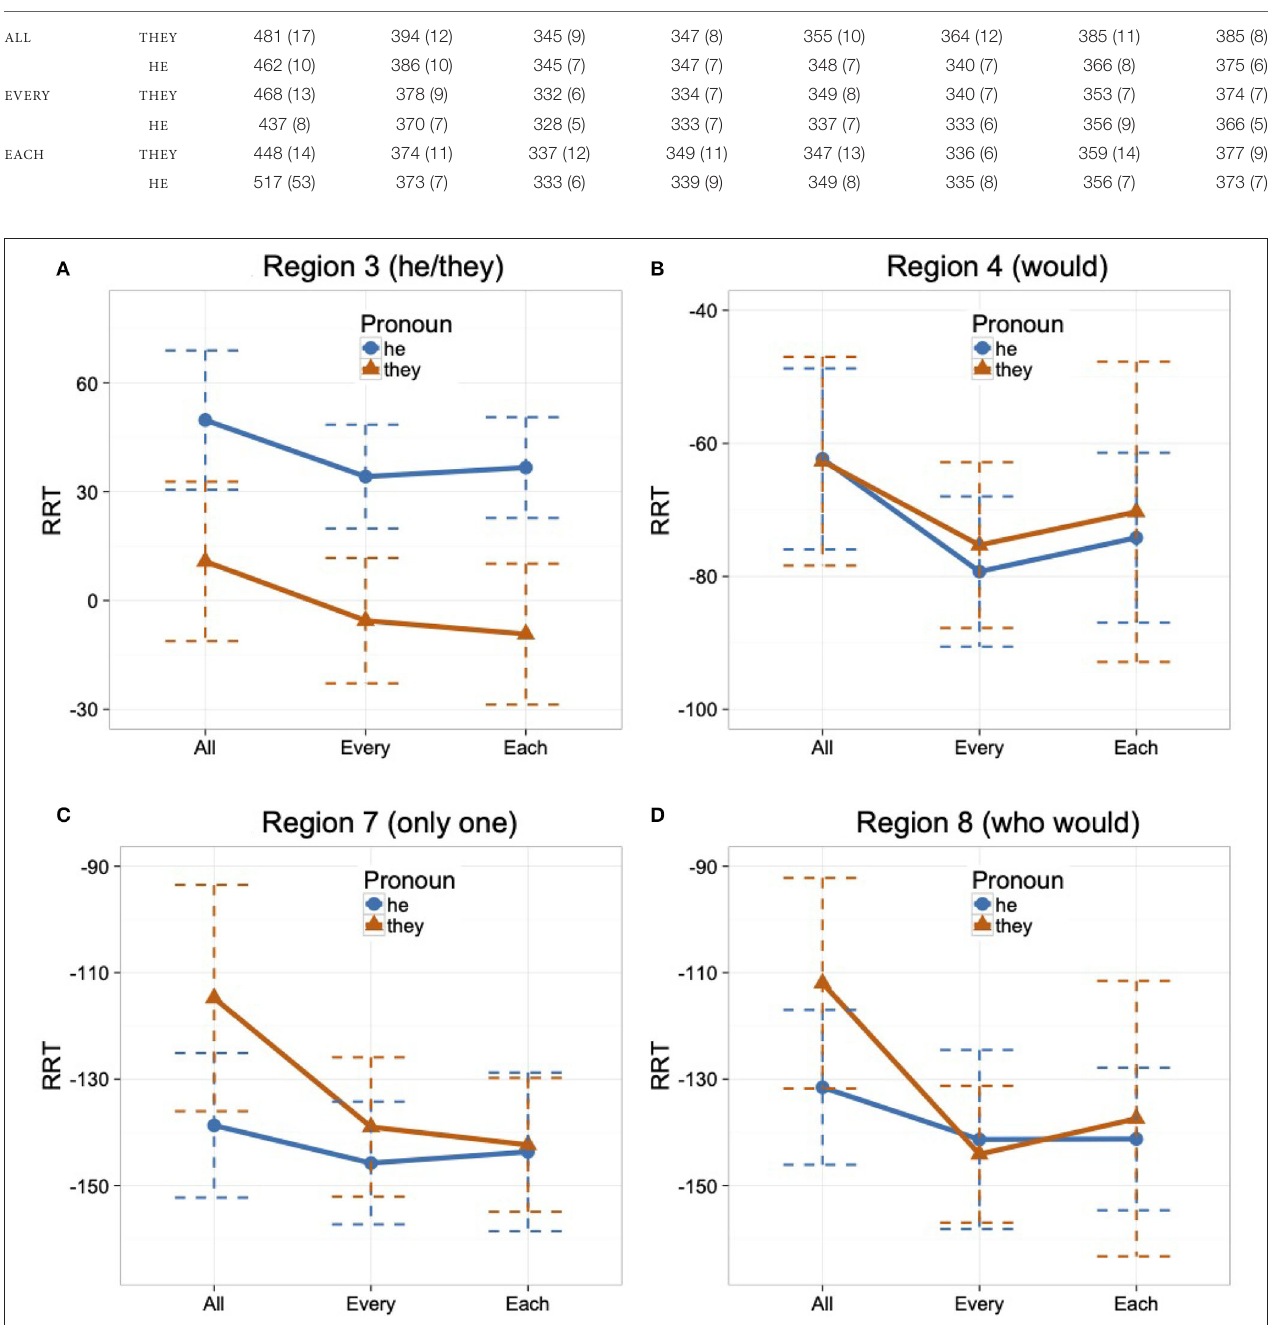
FIGURE 3 | Mean RRTs by the condition in Regions 3, 4, 7, and 8 with standard errors (A–D) , Experiment